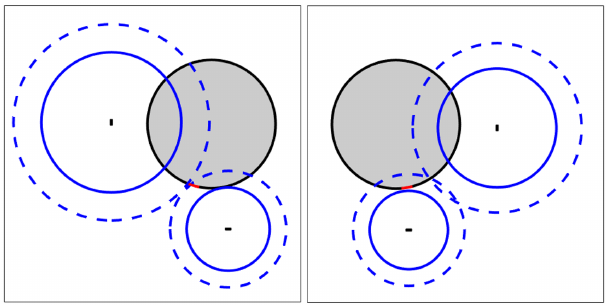
FIG. 9. 2D example of trilateration, for direct line of sight propagation for test 1 (left) and test 2 (right). Cavity is represented seen from above by a grey disk bordered by dark circle corresponding to its equator. Blue plain circles have radii equal to the time propagation for corresponding OST multiplied by 20 m = s. Dashed circles have radii equal to the time propa- gation for corresponding OST multiplied by 28 m = s. OSTs are represented by small dark rectangles, and quench position detected by temperature mapping system is in